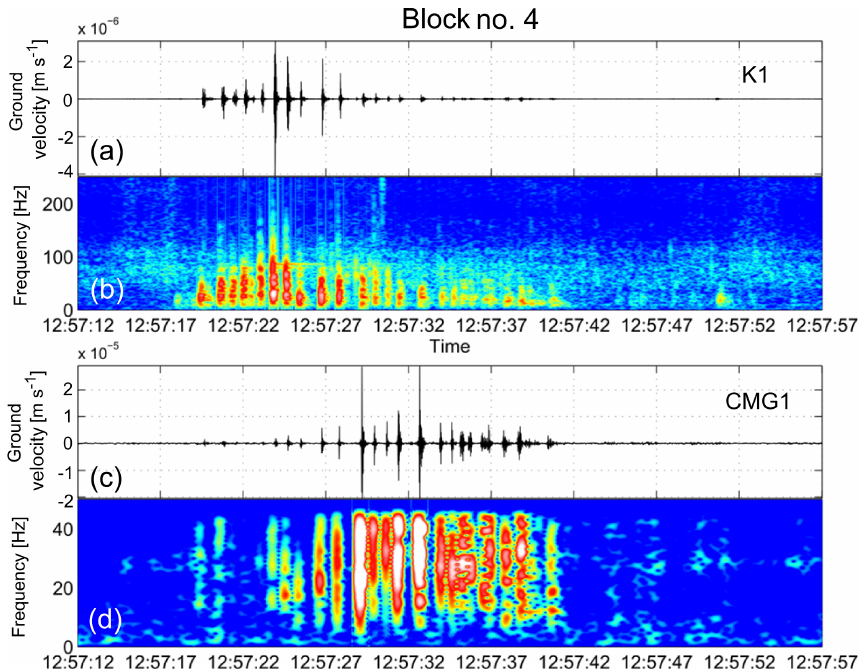
Figure 2. (a) Signal recorded at the short-period station located on the upper part of the slope and (b) corresponding spectrogram, generated by block number 4 (mass of 209kg). (c) Signal recorded at the broadband station located on the lower part of the slope and (d) corresponding spectrogram, generated by block 4.